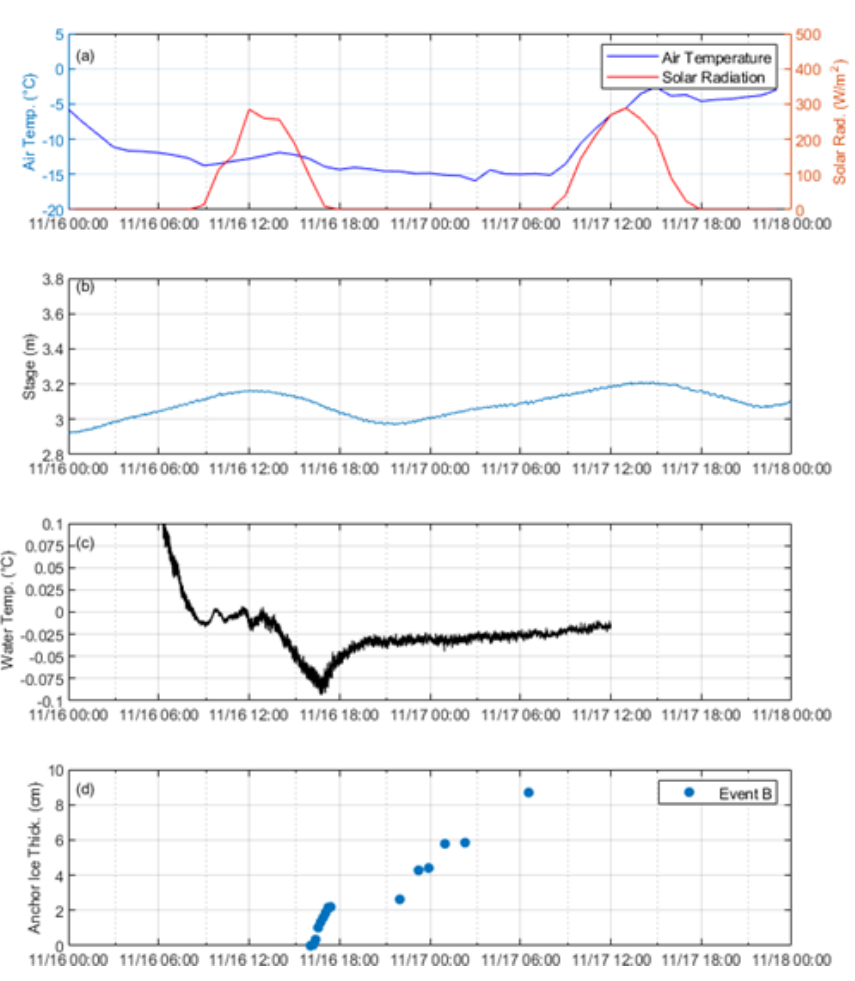
Figure 6. Time series of results of DEP-2 showing (a) air temperature and incoming solar radiation, (b) water depth at the WSC gauge #05DF001, (c) water temperature on the substrate, and (d) anchor ice thickness above the substrate for Event